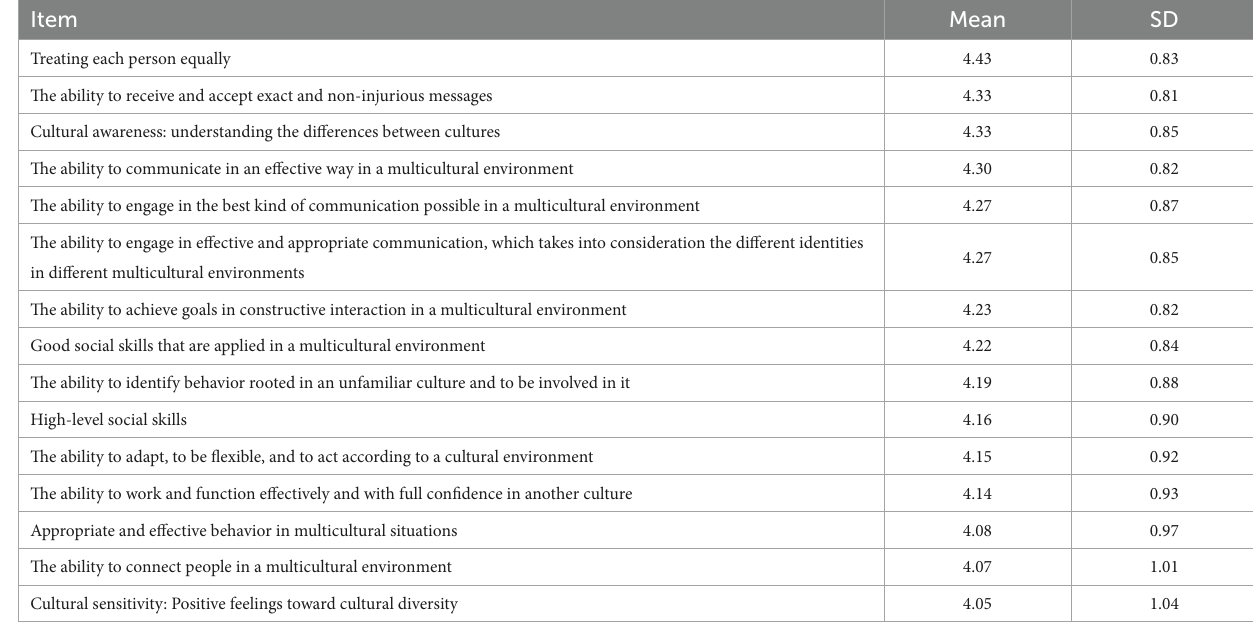
TABLE 1 Means and standard deviations of the statements on cultural competence ( N = 223).